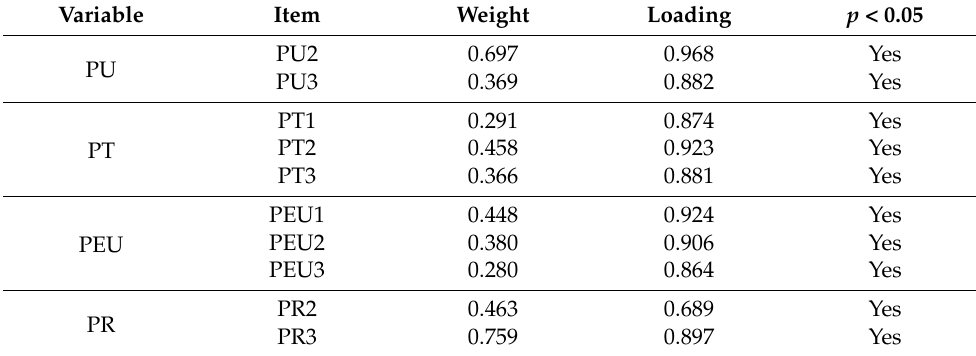
Table 5. Results for the formative variables.